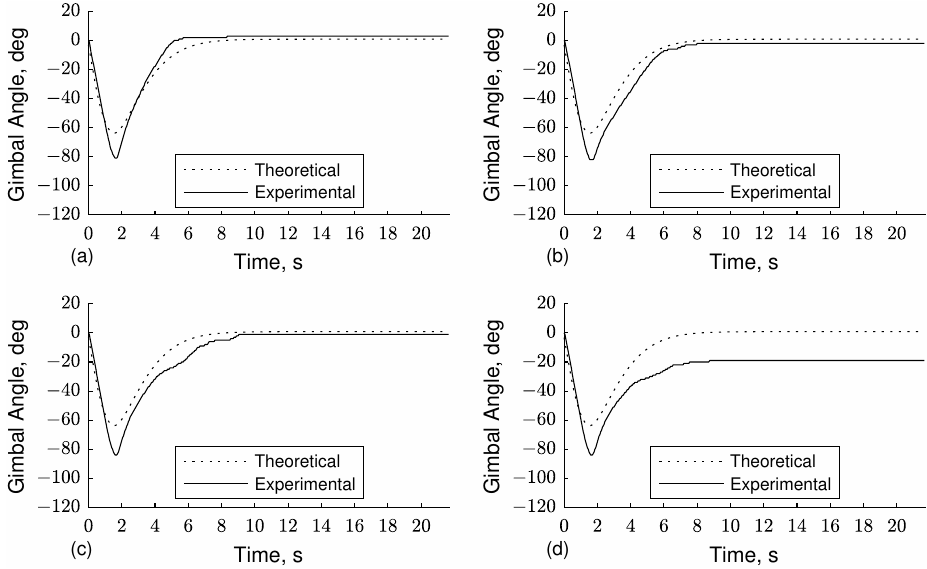
Figure 11. Gimbal angles for 180 deg manoeuvre, ( a ) δ 1 , ( b ) δ 2 , ( c ) δ 3 , ( d ) δ 4